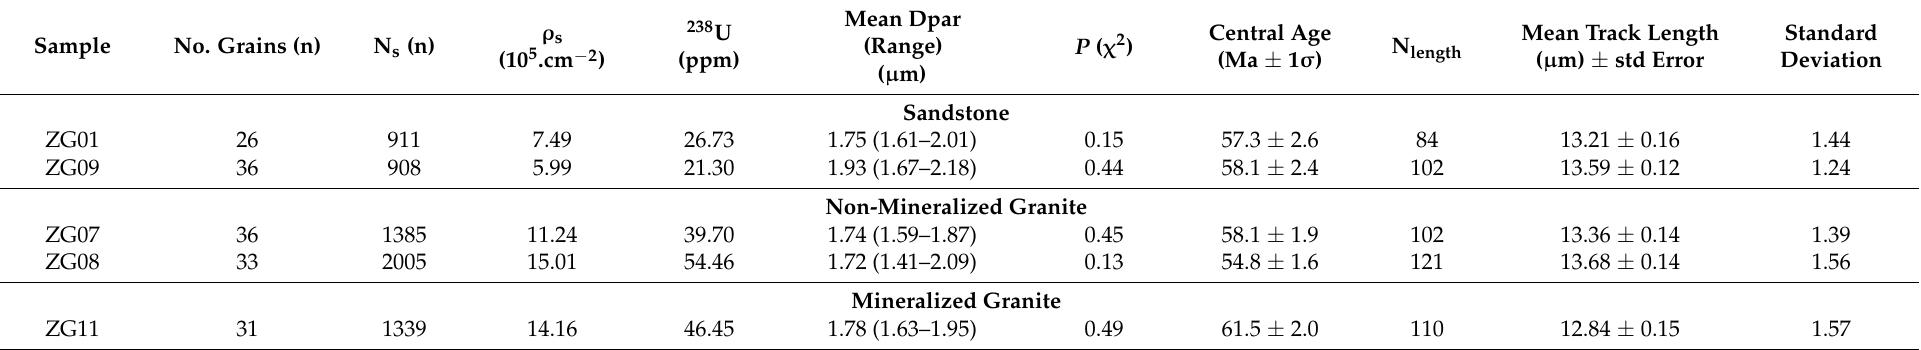
Table 3. Apatite fission track data from the Lujing uranium ore field region, South